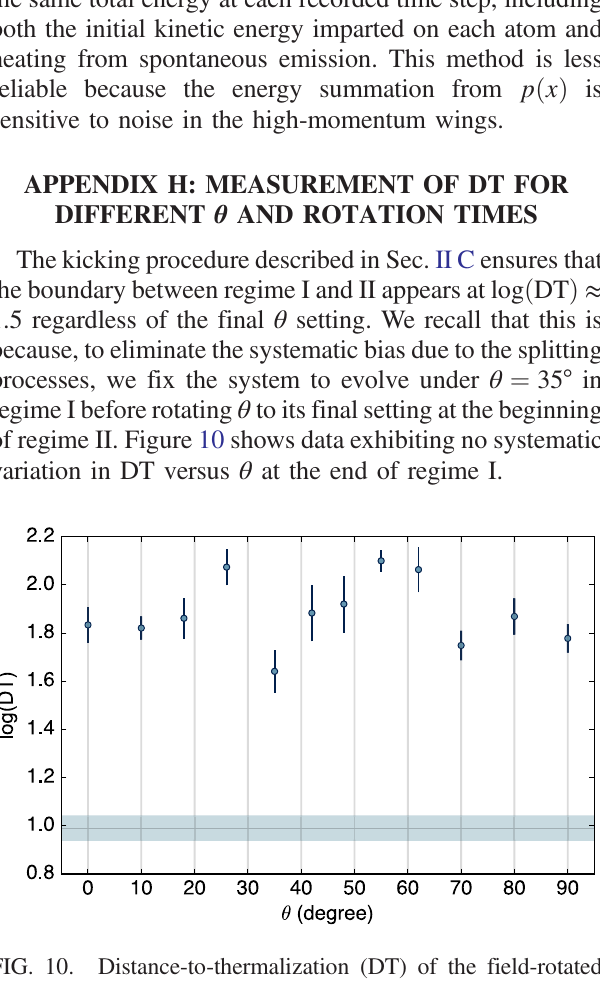
FIG. 10. Distance-to-thermalization (DT) of the field-rotated state near the end of regime I for each θ value investigated. The blue horizontal line is the mean noise floor, and the light blue band represents its 1 σ uncertainty.